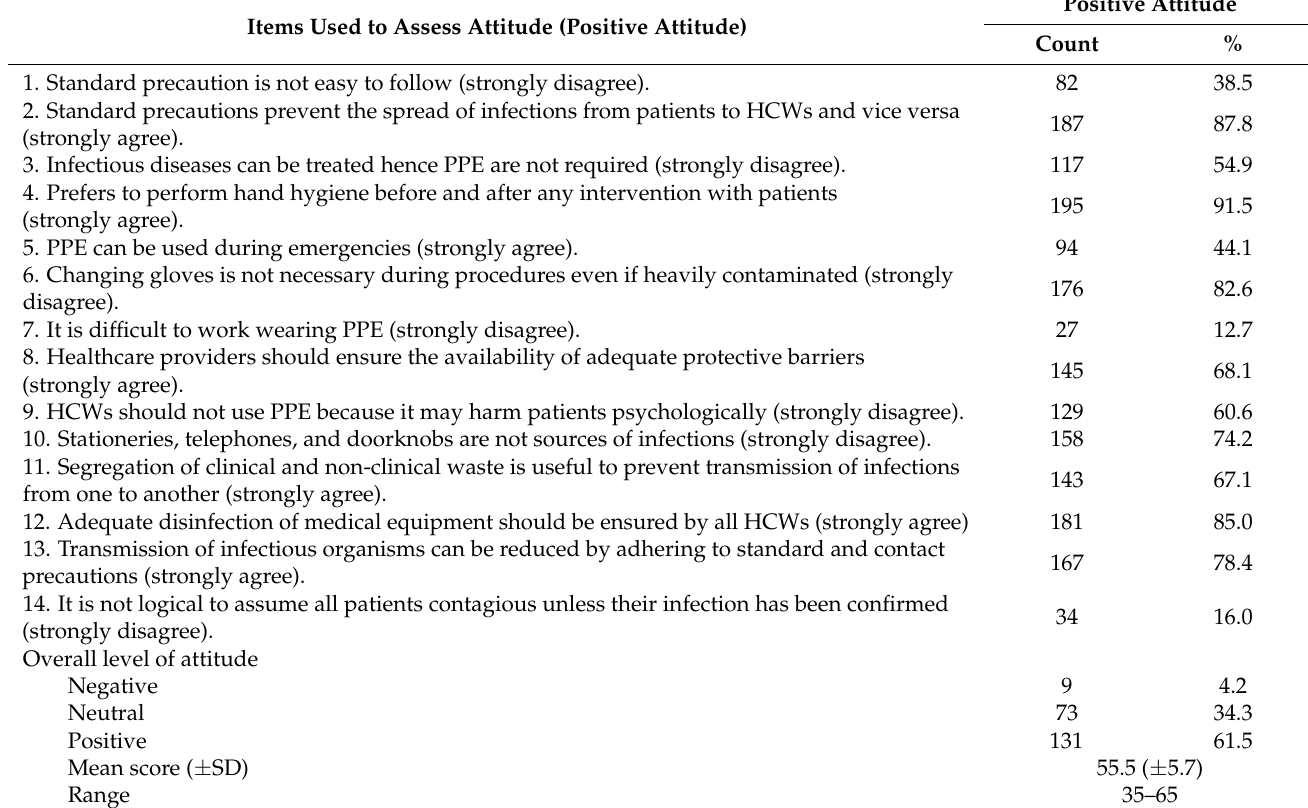
Table 3. Attitude of HCWs towards standard infection control precautions, Qassim University Hospital,